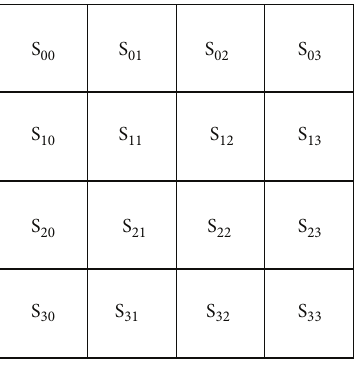
Figure 1: Internal state of AES- 192 / 256 and